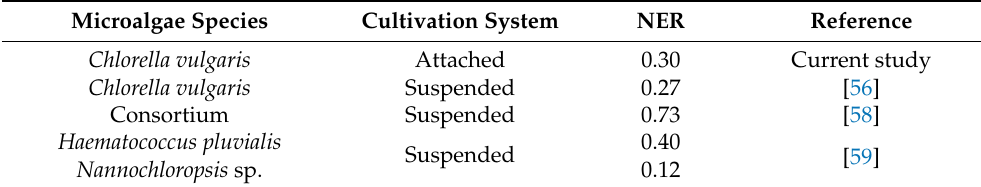
Table 6. Direct processes producing 1 g of lipid from attached microalgal biomass grown on palm decanter cake under irradiation with yellow light.